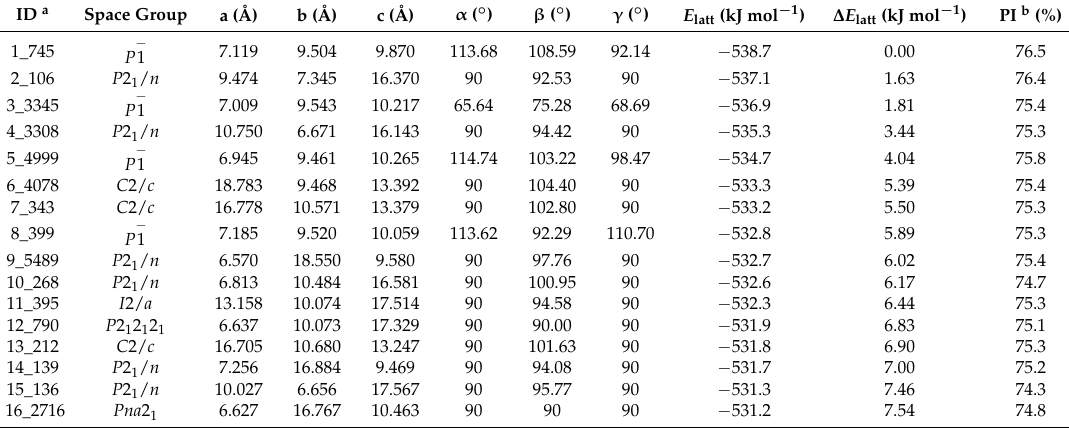
Table 1. Computationally generated low-energy PBE-TS neocuproine HCl anhydrate structures.